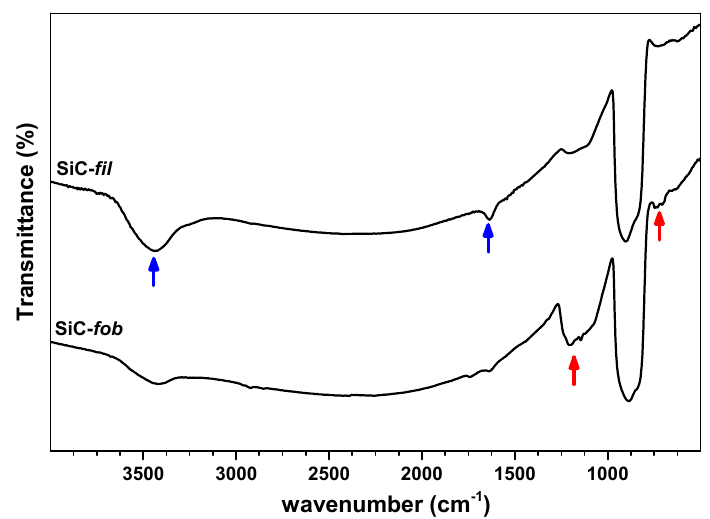
Figure 2. FT-IR spectra of the membrane material, before (SiC- fil ) and after modification (SiC- fob ). The blue arrows indicate the signals typical of the hydrated layer at the SiC- fil surface, whereas the red arrows evidence the signals typical of the C–F vibrations in the SiC- fob spectrum.